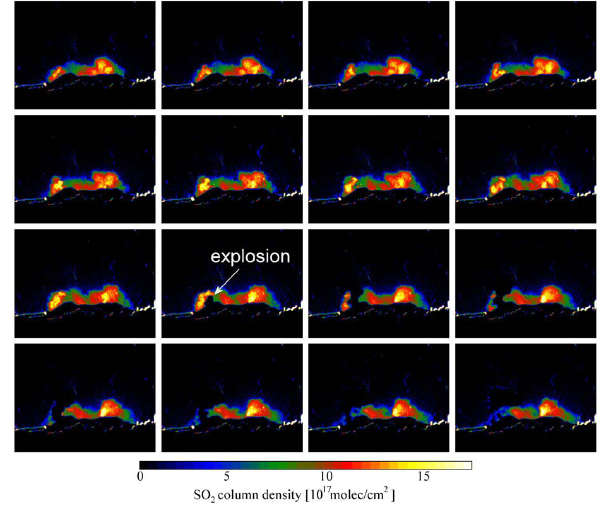
Figure 12. Time series of SO 2 images recorded at Mt Etna on October 15, 2007 beginning at 13:00 local time. The time gap between each of the depicted images is 21 seconds. In the 10 th image, a dark cloud can be observed rising up from the vent on the eastern flank of the south-east crater. As UV-radiation cannot sufficiently penetrate this ash-rich plume, the signal from the volcanic plume behind the ash cloud is blocked, resulting in an area of decreased SO 2 column density.